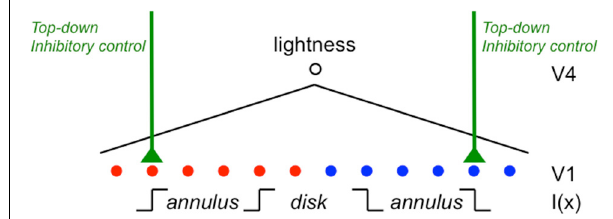
FIGURE 8 | A cortical mechanism that utilizes top-down feedback to perform different lightness judgments given different assumptions about the illumination with the same disk-annulus stimulus. The proposed cortical circuit by which the luminance step at the outer annulus edge in an incremental disk-annulus display is either included or excluded from the computation of the disk lightness to instantiate either of the two ideal observer models whose behavior is illustrated in Figure 7 . When the outer annulus edge is interpreted as an illumination edge, the responses of edge detector neurons in V1 are suppressed by a top-down neural gain control. This inhibitory gain control may originate from prefrontal cortex and act either directly on V1 neurons—by shutting down cortical columns containing neurons that encode edges tuned to a particular orientation and contrast polarity, and located in the parts of the visual field corresponding to the outer edges of the annulus—or indirectly via IT (see text for further details). Similar inhibitory connections are assumed to project to all edge sensitive neurons in V1, but only the connections that are relevant to the lightness matching task for incremental disk-annulus stimuli are